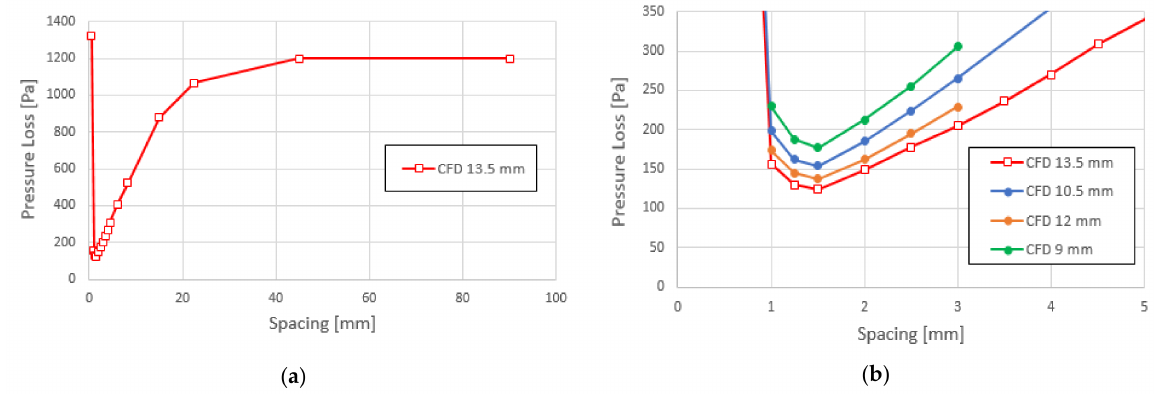
Figure 19. Calculated pressure drop of pleated filter at flow rate 70 L/min. ( a ) Pleat height 13.5 mm; ( b ) Detail of calculated pressure drop for pleat height between 9 and 13.5 mm (right).